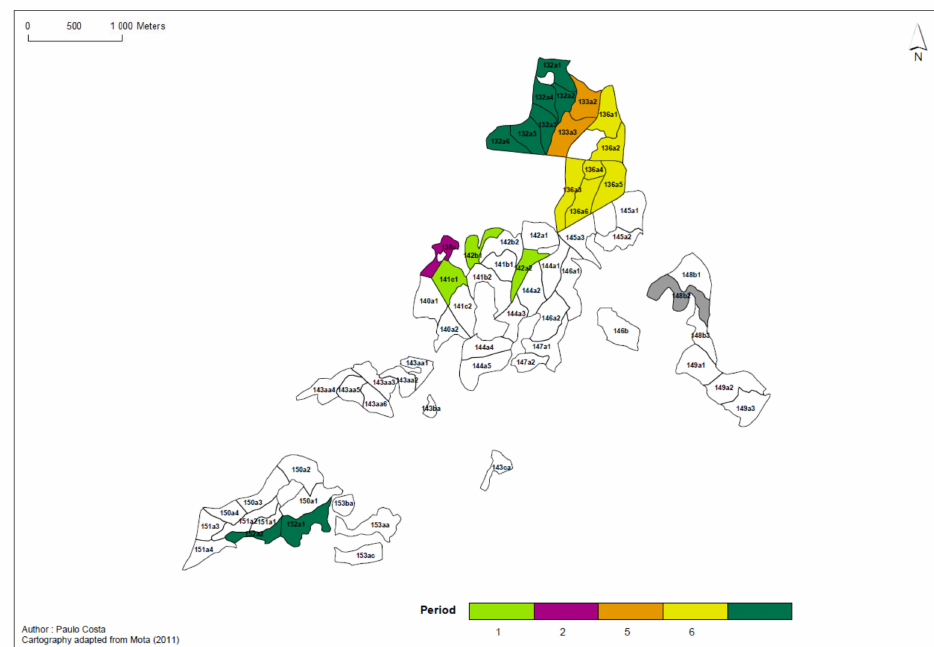
Figure 7. Map of thinning to be carried out for periods 1 to 10 of the planning